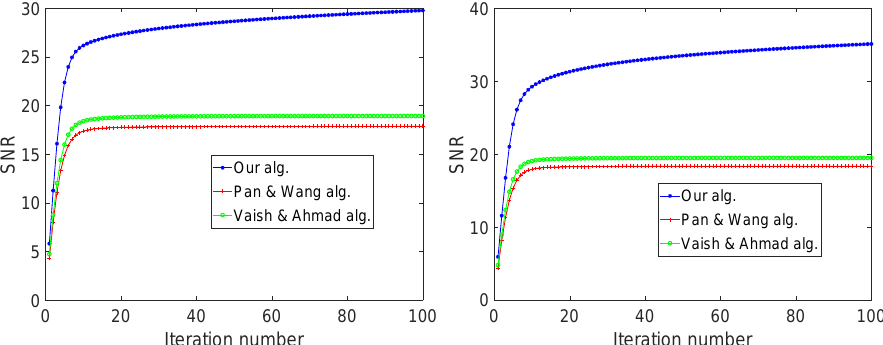
Figure 5. Example 2: Graphs of signal-to-noise ratio (SNR) values against the number of iterations for Cameraman ( left )and Pout ( right ). Table 3. Time (s) for restoring the images for each algorithm. Our